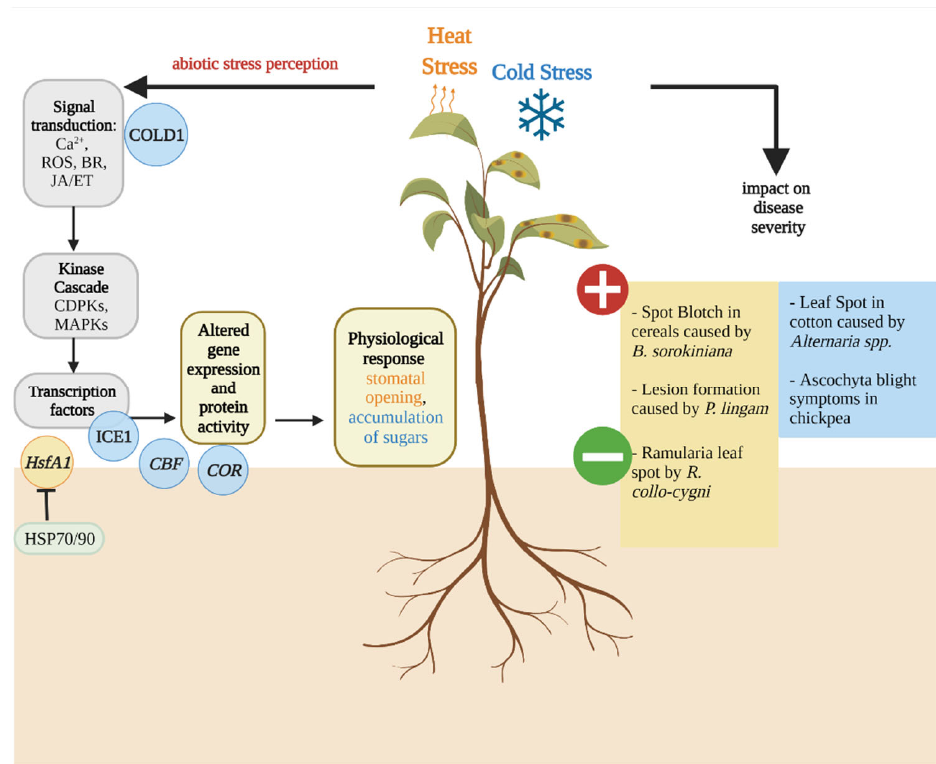
Figure 1. Overview of host temperature stress signalling pathways and the impact of temperature stress on Dothideomycete-induced disease severity. Figure 1 highlights the signalling pathways ( left ) and effects of cold (blue) and heat stress (orange) on the severity of several Dothideomycete-induced diseases ( right ). The cold response cascade presented is shared between A. thaliana and rice. The membrane protein chilling tolerance divergence 1 (COLD1) triggers the release of calcium ions (Ca 2+ ) upon the perception of freezing and chilling stress. Mitogen-activated protein kinase (MAPK) mediates this signalling via the expression of transcription factors such as inducer of C-repeat binding factor (CBF) expression 1 (ICE1), which in turn activates the expression of cold responsive ( COR ) genes via transcriptional activators such as CBF. The ICE1-CBF-COR pathway is a key response pathway to cold stress. The change of membrane fluidity upon heat stress is proposed to induce a signalling cascade mediated by Ca 2+ . The heat shock proteins HSP70/90 repress the activity of the heat stress transcription factor HsfA1, a master regulator of thermotolerance in the absence of heat stress. Upon heat stress, this regulator is activated and targets downstream transcription factors, which in turn modulate the synthesis of chaperones and enzymes involved in degradation of unfolded proteins and scavenging of reactive oxygen species